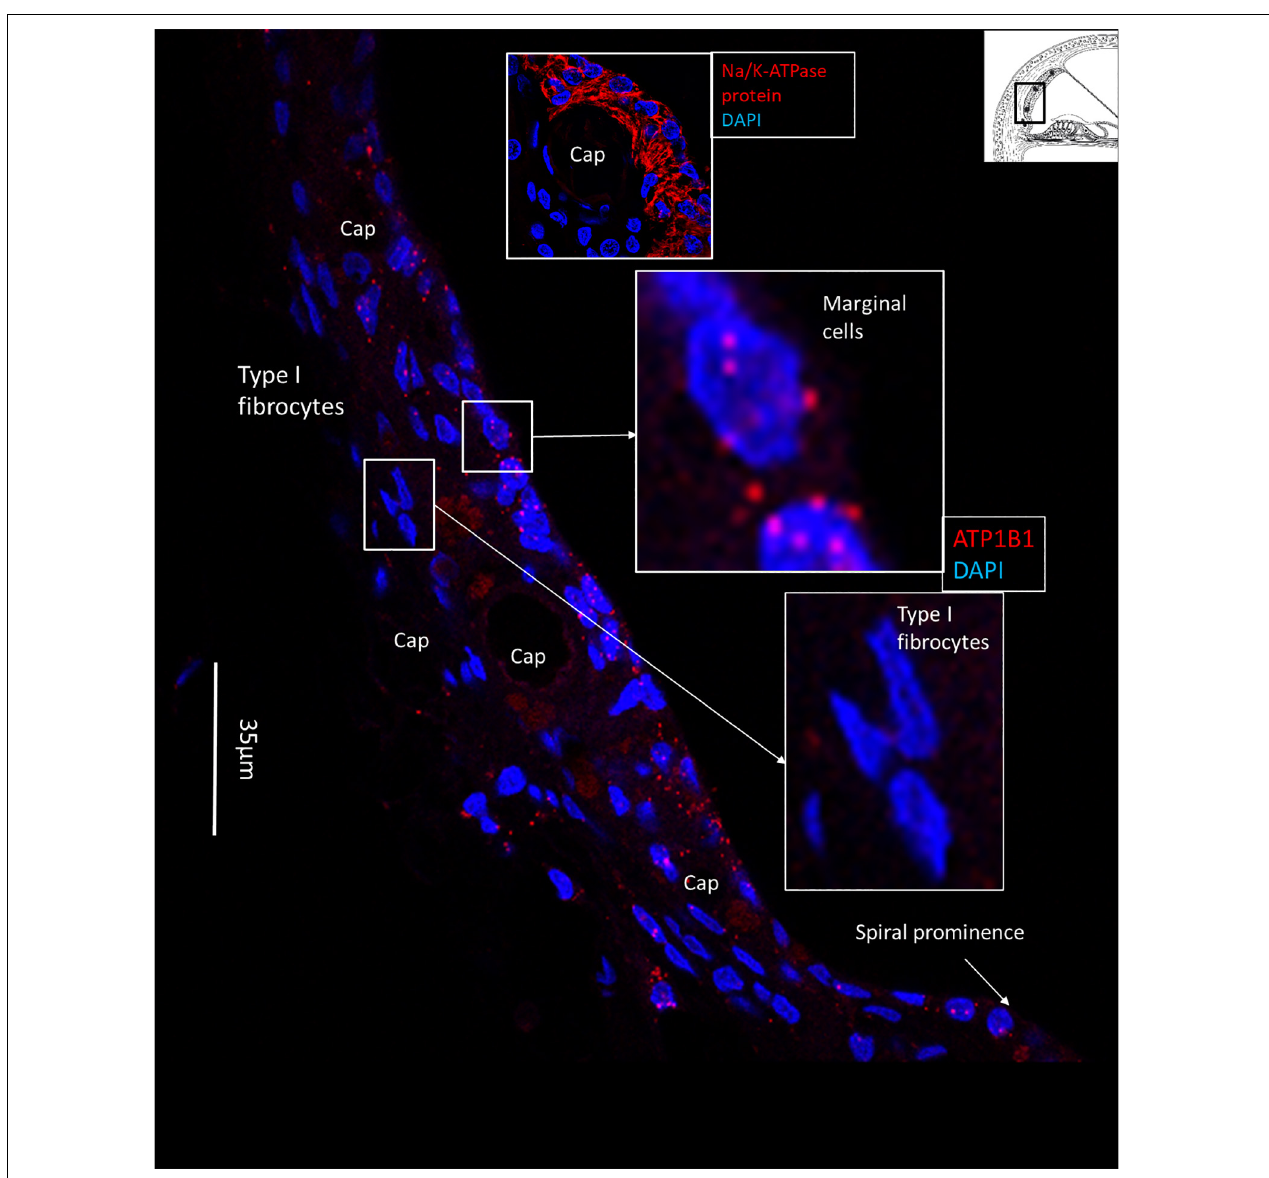
FIGURE 2 | SR-SIM of the human lateral cochlear wall. ATP1B1 gene transcripts are mainly expressed in marginal cells. Type I fibrocytes and blood vessels lack expression of ATP1B1 . Some cells located near the spiral prominence contain ATP1B1 gene transcripts. Right inset shows expression of ATP1B1 in marginal cells. Left inset shows basal cells at higher magnification with no ATP1B1 gene transcripts